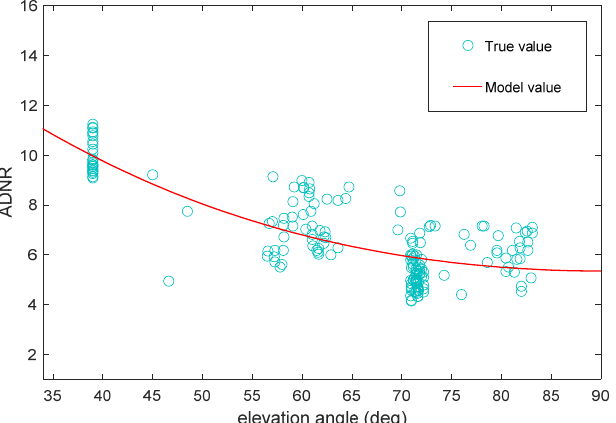
Figure 2. Relationship between satellite elevation angle and ADNR at a significant wave height of 2 m. 2